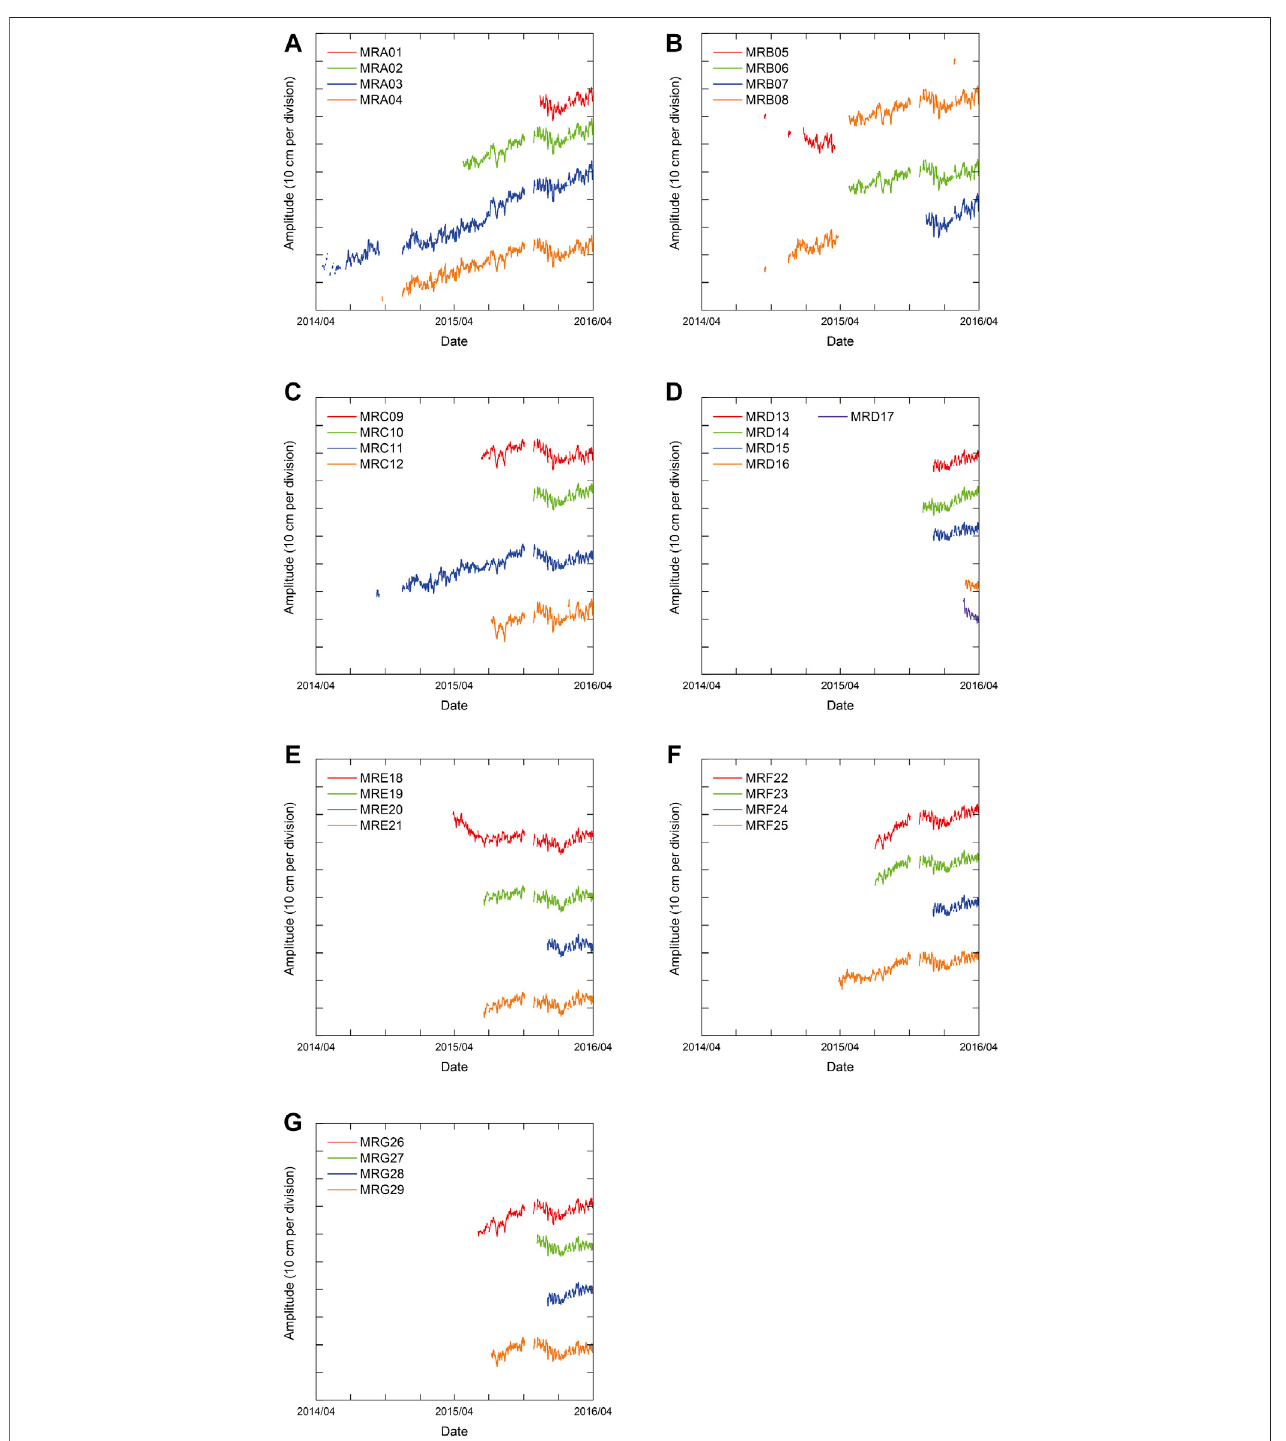
FIGURE 5 | (A) Trend component of pressure sensors analyzed by Baytap08 of MRA observatories. Each tick on the vertical axis represents 10 cm water depth change. (B) MRB, (C) MRC, (D) MRD, (E) MRE, (F) MRF, and (G) MRG observatories are presented in the same form as (A) .